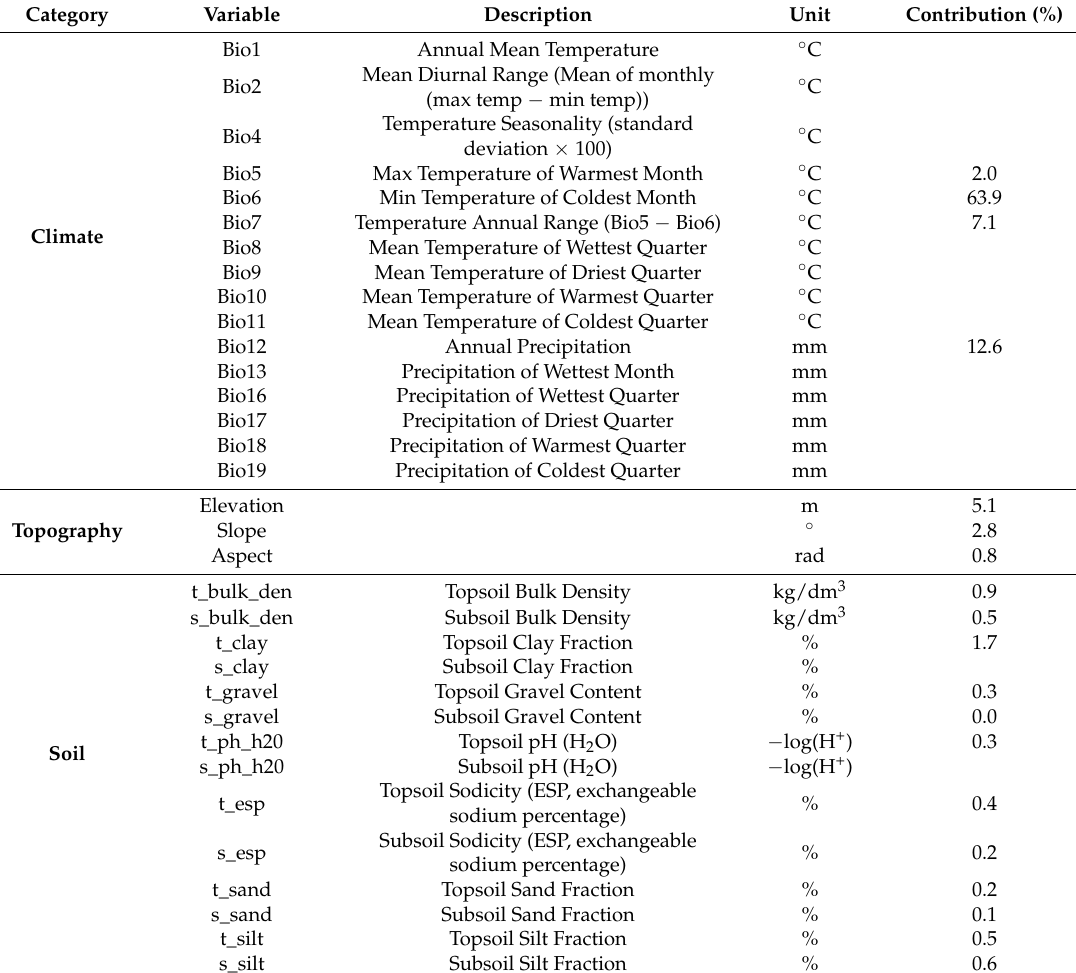
Table 1. Environmental variables used in this study and their percentage